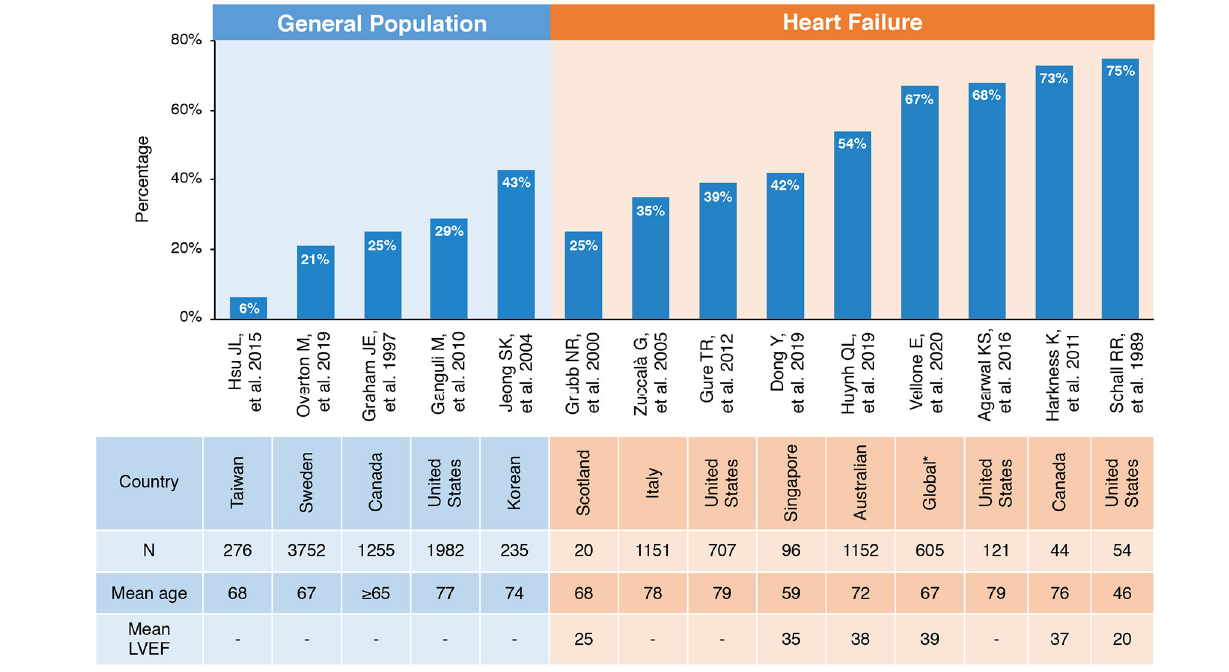
FIGURE 2 | Prevalence of CI in general population and patients with HF. *Including Sweden, Italy, Israel, The Netherlands, Germany, and the United States. CI, cognitive impairment; HF, heart failure; LVEF, left ventricular ejection